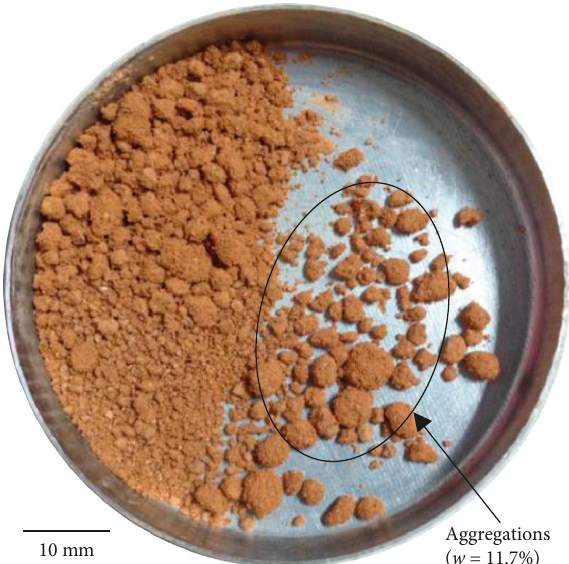
Figure 8: Formation of aggregates after mixing water with oven- dried clay